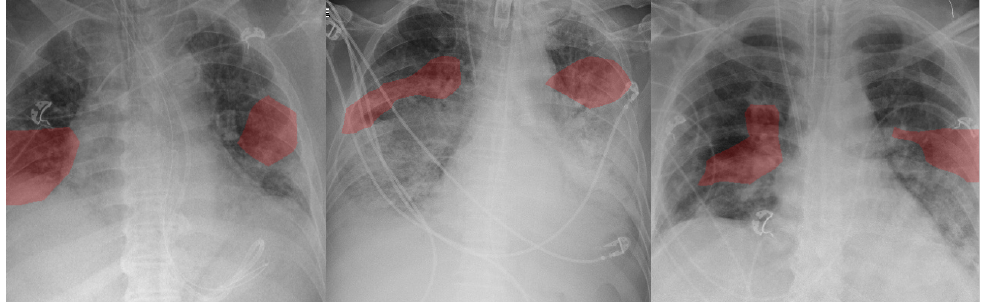
Figure 3. Examples of Level 2 severity patient cases and the associated critical factors (highlighted in red) as identified by GSInquire [21] during explainability-driven performance validation as what drove the decision-making behavior of COVID-Net CXR-S. ( left ) Case 1, ( middle ) Case 2, ( right ) Case 3. Ra- diologist validation showed that several of the critical factors identified are consistent with radiologist